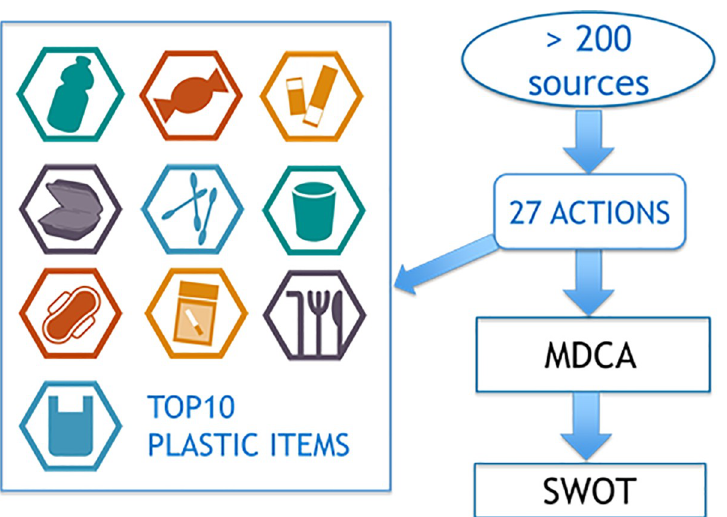
Fig 1. Summary of our analysis approach: Multi-Criteria Decision Analysis (MCDA), Strengths Weaknesses Threats and Opportunities (SWOT).